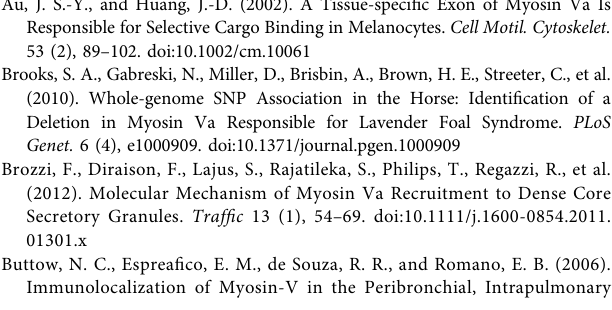
Supplementary Figure S2 | Myo5a localization and variant expression in bladder mucosa. (A) Image from confocal microscopy of bladder sections stained with Myo5a antibody (red staining) and counterstained with urothelial marker uroplakin-3 (UPIII, green staining). Differential interference contrast (DIC) image was superimposed to visualize tissue anatomy. Myo5a showed abundant immunoreactivity in nerves fi bers running within the muscle bundles as well as in the lamina propria . Less intense staining for Myo5a was detected in the urothelial layers as shown by the merged image (Scale bar = 200 µm; Mag ×20). (B) cDNAs from bladder mucosa total RNA of WT (black circles, N = 4) and DBA animals (gray squares, N =3)wereassayedbyRT-PCRintriplicateforMyo5aexonBorexonF,as indicated, with their speci fi c TaqMan assays, and for 18S rRNA as an internal control. Expression was determined by the ΔΔ Ct method and the average % intensity, shown by the horizontal line, ± SEM was graphed relative to WT. Expression of exon B was not detected (nd) in either WT or DBA mucosa; exon Fwasdetectedbutexpressiondidnotdifferbygenotype( p =0.52). (C) cDNAsfrom mucosae of WT ( N = 3) and DBA ( N = 3) animals were used for nested PCR with primer pair 3 which spans alternative exon D sequence. Products were digested with Ban II to indicate the presence of exon D, and electrophoresed on a 2% MetaPhor agarose gel with a 50 bp mass standard ladder to assess fragment sizes. The mobility of bands without (-D) and with (+D) exon D are shown at the right. (D) The intensity of each band as a percentage of the total intensity in each lane was determined, and the average % intensity ± SEM of +D products, shown by the horizontal lines is graphed for all replicates of each genotype. There was more exon D-containing PCR product seen in WT mucosa (black circles) compared to DBA mucosa (gray squares) (* p < 0.05). (E) Nested PCR was also performed with primer pair 4,inwhichthereverse primeriswithinexonF. Products weredigested withBan II and electrophoresed with a 100 bp mass standard ladder, to indicate the proportion of exon F-containing transcripts that also contain exon D. The second and third lanes of this gel contain an undigested aliquot of WT and DBA mucosa from these PCR reactions, respectively. The mobility of bands without ( − D